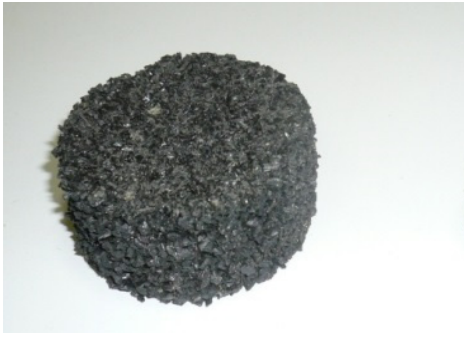
Figure 6. Ground Fraction of Recycled Rubber .